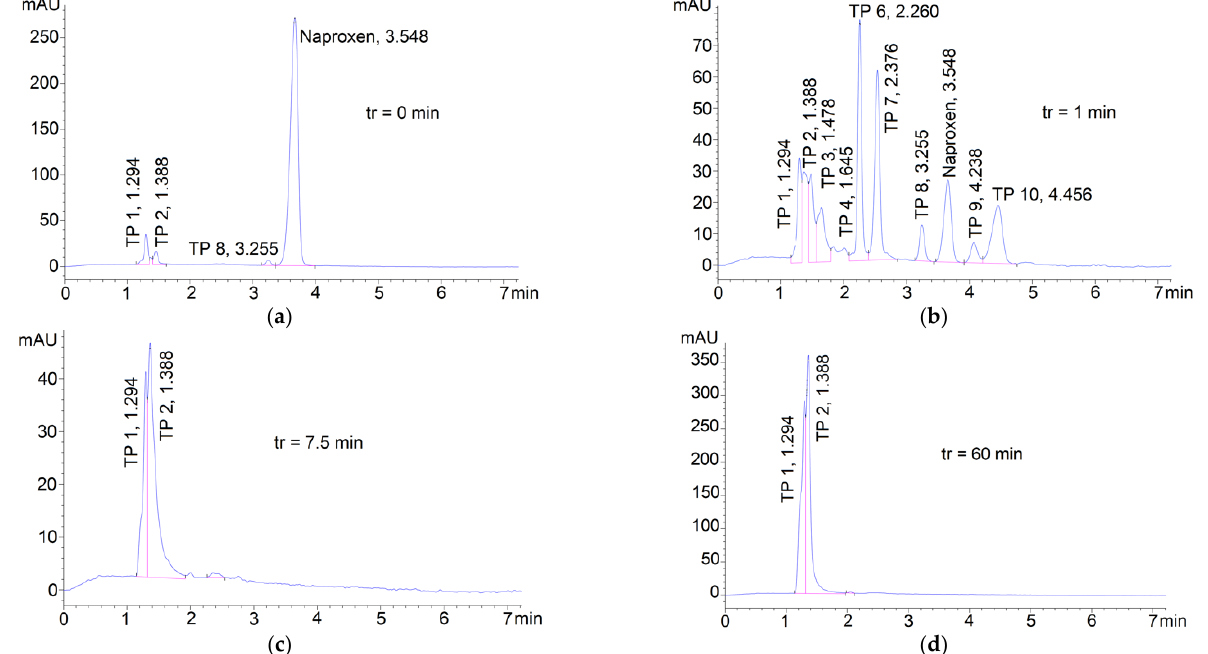
Figure 5. Naproxen and its transformation products (TP) detected in the sludge at different reaction times with the highest current density (20.3 mA/cm 2 ) and lowest pH (3). ( a ) tr = 0 min; ( b ) tr = 1 min; ( c ) tr = 7.5 min; ( d ) tr = 60 min. TP refers to transformation products.